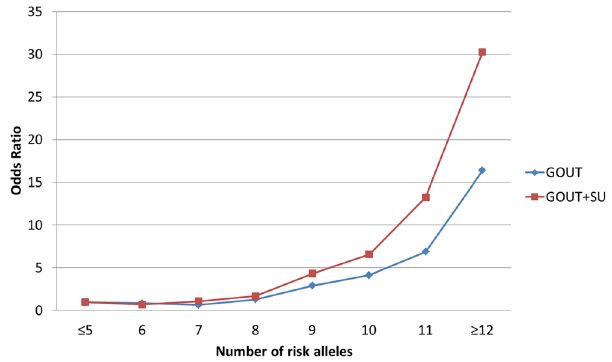
Figure 1. Cumulative effect of the associated variants from gout associated loci and gout + SU associated loci on gout incidence. For the analysis using variants from the gout associated loci ( GOUT , blue color), seven variants (rs1260326 (L446P)of GCKR , rs11722228 of SLC2A9 , rs12505410 and rs2231142 (Q141K)of ABCG2 , rs4073582 of CNIH2 , rs671 (E504K) of ALDH2 ( MYL2-CUX2 ) and rs9895661 of BCAS3 ) were included and eight bins ( ≤ 5, 6, 7, 8, 9, 10, 11, and ≥ 12) were generated. Using the ≤ 5 bin as the reference category, the OR and 95% CI for each of the other bins (6, 7, 8, 9, 10, 11, and ≥ 12) were assessed using logistic regression. For the combined analysis of variants from gout and SU associated loci ( GOUT + SU , red color), we also used the ≤ 5 bin in the gout associated loci analysis as reference, and excluded the individuals with ≤ 8 risk alleles in the SU associated loci analysis from the test bins (Supplementary